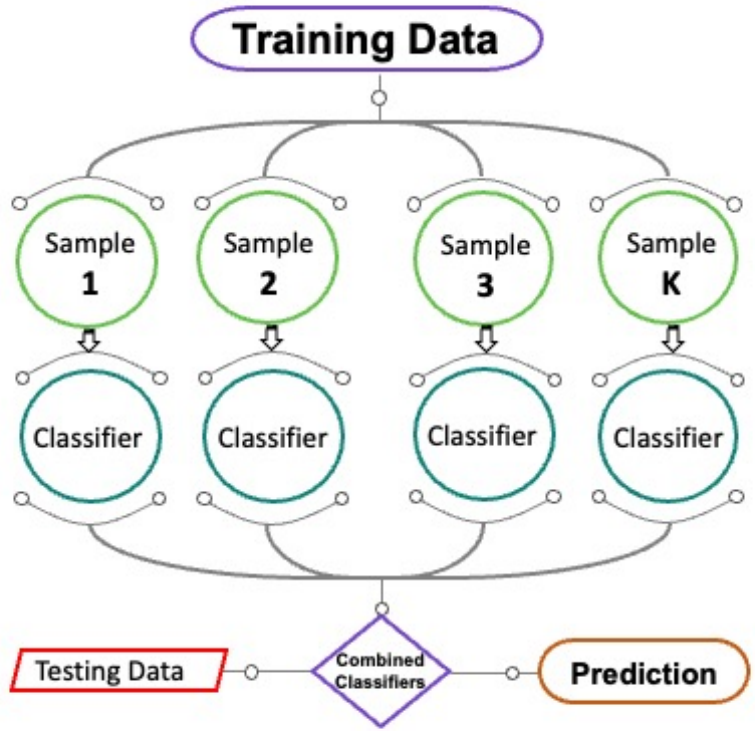
Figure 5. Schematic interpretation of bagging regressor model [80] .